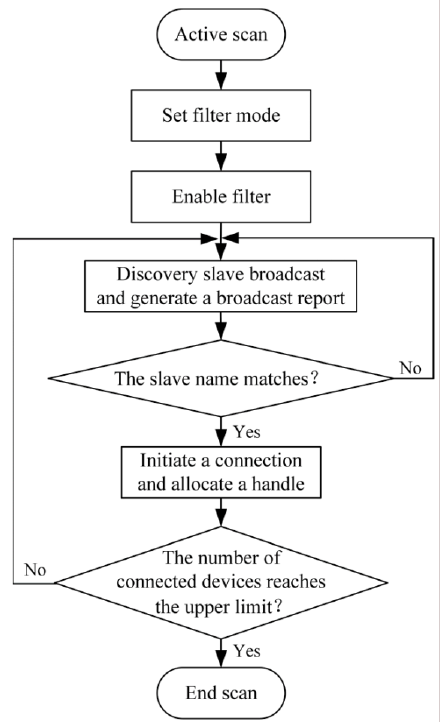
Figure 4. Bluetooth master and slave connection process flow chart.